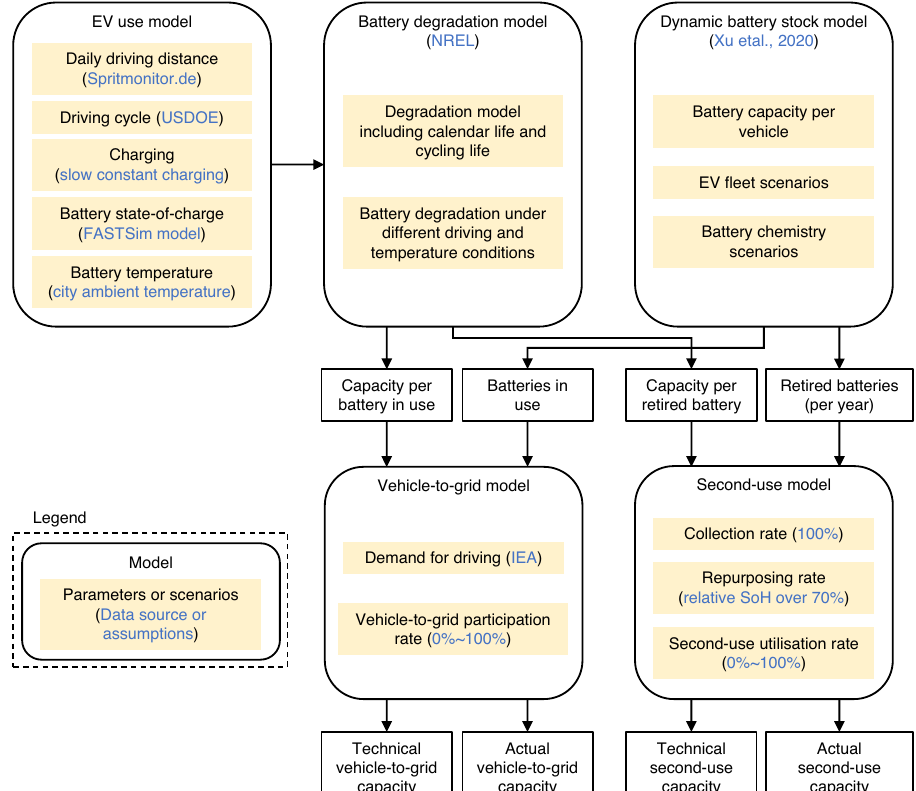
Fig.1|ModelframeworklinkingEVusemodel,batterydegradationmodel,and dynamicbatterystockmodels. Seelegendforuseofcolours.Square,whiteboxes indicatemodeloutputs.Pleaseseedetailsforthemodelframeworkinthemethods